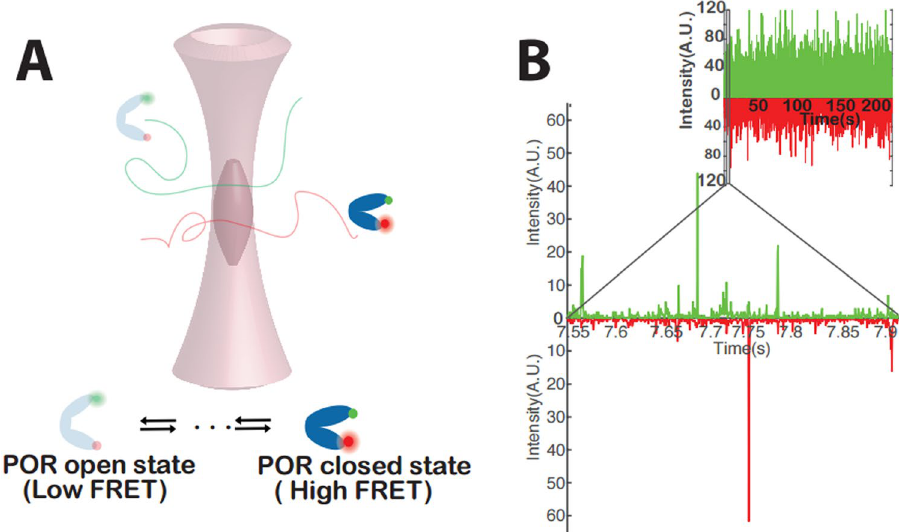
Figure 2. (A) A cartoon illustration of the experimental setup (B) Typical trajectory of detected photons recorded from ND reconstituted POR freely diffusing in solution. Coincident bursts correspond to an individual dual labeled POR traversing the diffraction-limited confocal volume. POR labeled with Cy3 or Cy5 only appear as single channel bursts. Inset shows an entire 250 s